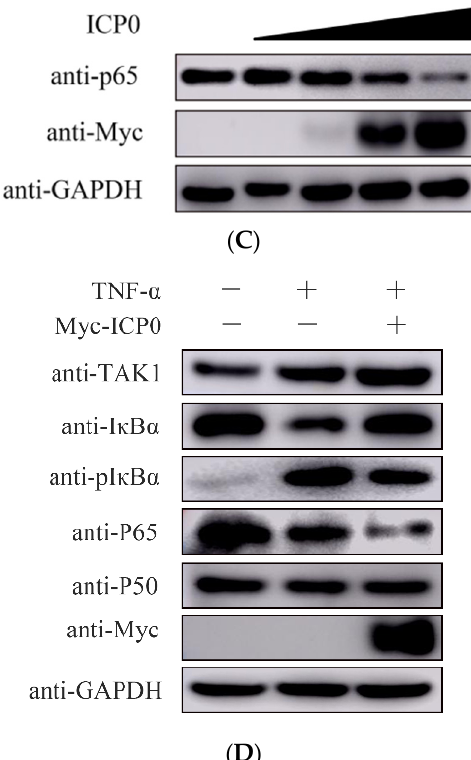
Figure 3. p65 may be a target of pseudorabies virus ICP0 protein. ( A ) PK15 cells were mock infected or infected with 1 MOI PRV for 1 h, 2 h, 3 h, 4 h and 5 h. Then, cells were collected at the indicated time points. Western blot was performed for p65 expression detection (Left). The expression of ICP0 mRNA was detected by RT-qPCR (Right). GAPDH served as loading control. ( B ) PK15 cells were transfected with pCMV-Myc empty vector (EV) (1.0 µg) or Myc-ICP0 (1.0 µg) plasmids for 24 h. Then, cells were harvested and lysed for Western blot detection. Factors included in the NF- κ B signaling pathway such as TAK1, I κ B α , pI κ B α , p50 and p65 were detected. GAPDH served as loading control. The grey value of p65 relative to GAPDH was quantified. ( C ) PK15 cells were transfected with increasing concentrations of expression vectors for ICP0. After 24 h, cells were collected and lysed for p65 detection. GAPDH served as loading control. The grey value of p65 protein expression relative to GAPDH was also quantified. ( D ) PK15 cells were transfected with pCMV-Myc empty vector (EV) (1.0 µg) or Myc-ICP0 (1.0 µg) plasmids for 24 h. Then, cells were treated with or without 50 ng/mL recombinant human TNF- α and incubated for an additional 12 h. Western blot was performed for TAK1, I κ B α , pI κ B α , p50 and p65 detection with the indicated antibodies. GAPDH served as loading control.